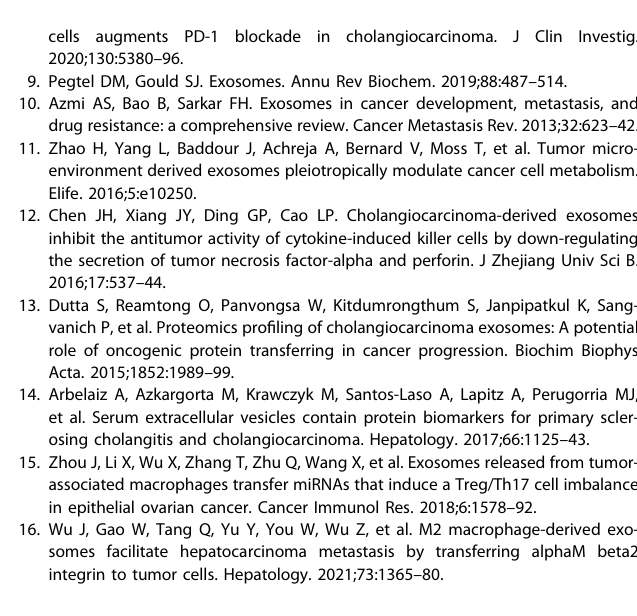
Fig. 8 Exosomal Hsa_Circ_0020256 mediated TAM-induced tumor progression in vivo via the miR-432-5p/E2F3 axis. RBE cells (1 × 10 7 ) were subcutaneously injected into nude mice. A The nude mice were sacri fi ced after 4 weeks. Images of the xenografts are shown. B Tumor volumes were calculated each week and a tumor growth curve is shown. C Xenograft tumor tissues were collected and the RNA was extracted. Hsa_Circ_0020256, miR-432-5p, and E2F3 expression were detected by real-time PCR. D E2F3, N-Cadherin, and E-cadherin protein expression in xenograft tumor tissues was detected by western blotting. E Tumor tissues were collected and fi xed for H&E staining and IHC was performed using Ki67 and E2F3 antibodies. F Tumor tissues and paracancerous tissues were fi xed for FISH assays, H&E staining, and IHC performed using Ki67 and E2F3 antibodies. G A schematic model showing how Hsa_Circ_0020256 in TAM-secreted exosomes induces the proliferation, migration, and invasion of CCA cells by sponging